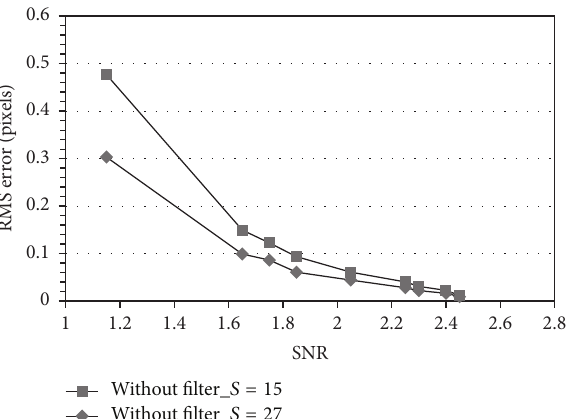
Figure 8: Effect of image SNR on rms displacement error without filtering using 15 × 15 and 27 × 27 source window sizes. Here LW = 11 pixels.